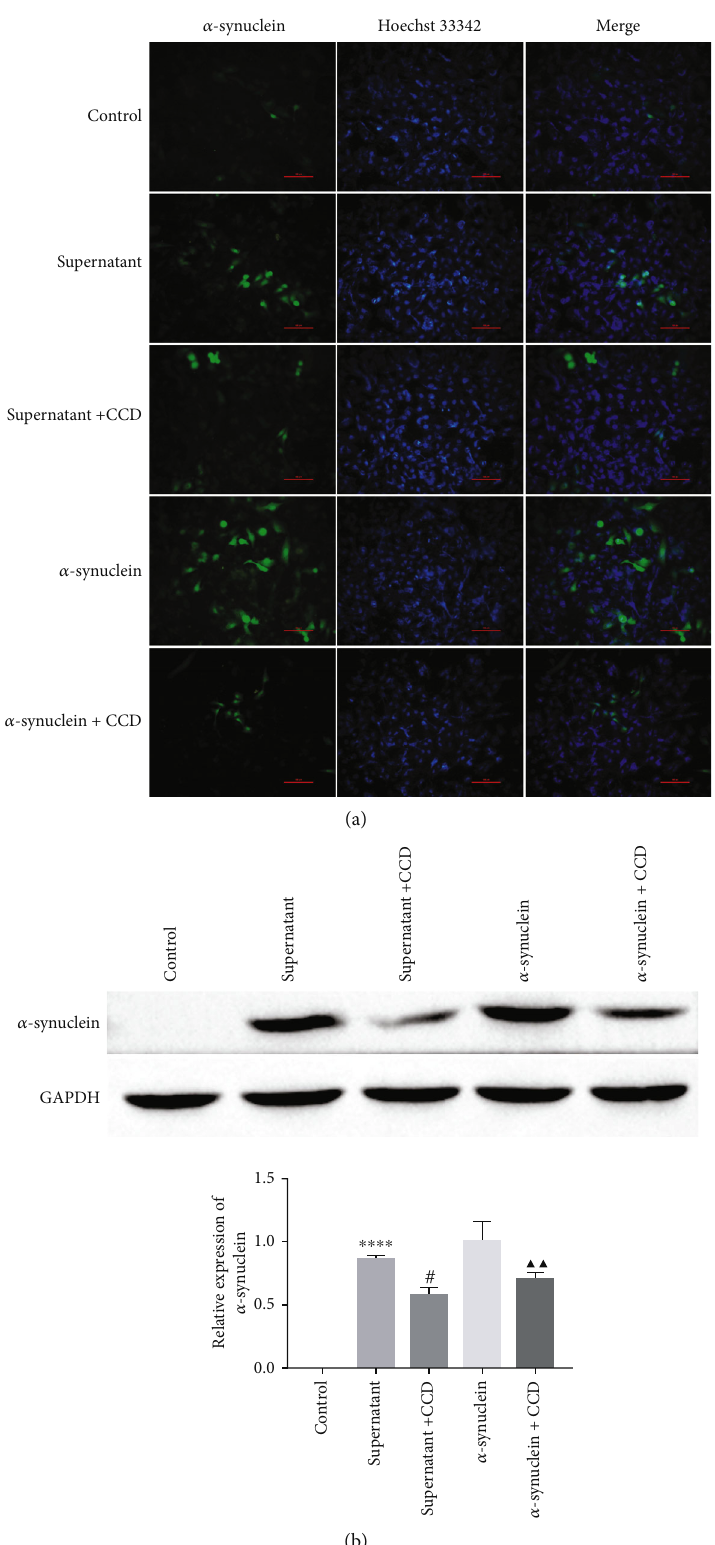
Figure 3: α -Synuclein enters microglia via cytophagy. (a) The expression of α -synuclein in BV-2 cells was detected by immuno fl uorescence. Scale bar = 100 px. (b) The expression of α -synuclein was detected by western blot, ∗∗∗∗ P < 0 : 0001 vs. control, # P < 0 : 05 vs. supernatant, and ▲▲ P < 0 : 01 vs . α -synuclein (note: control group: treated small glial cells (BV-2) with PBS; supernatant group: extracted rotenone-treated MN9D cell supernatant cocultured with BV-2 cells; CCD: phagocytosis inhibitor cytochalasin